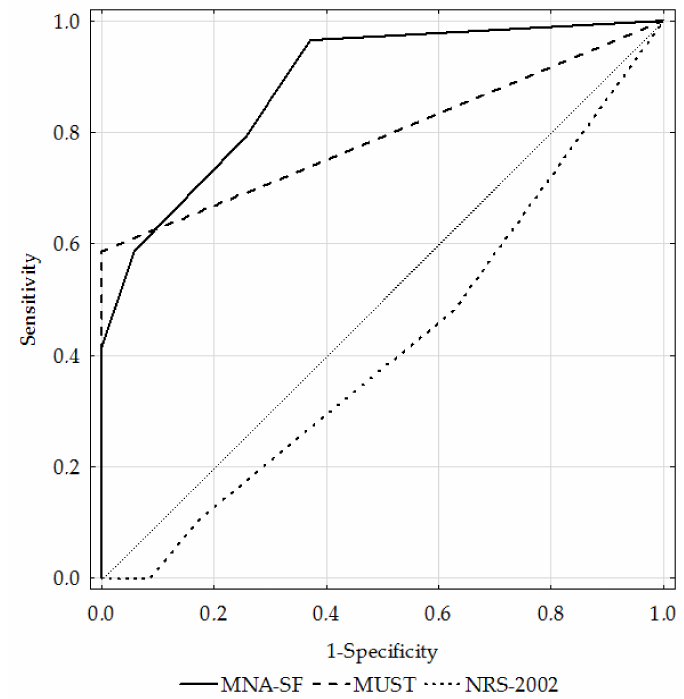
Figure 6. ROC curves for the MNA-SF, MUST, and NRS-2002 questionnaires against the GLIM criteria in the GOLD3+4 subgroup. Notes: MNA-SF, Mini Nutritional Assessment—Short Form; MUST, Malnutrition Universal Screening Tool; NRS-2002, Nutritional Risk Score; GLIM, Global Leadership Initiative on Malnutrition; GOLD, Global Initiative for Chronic Obstructive Lung